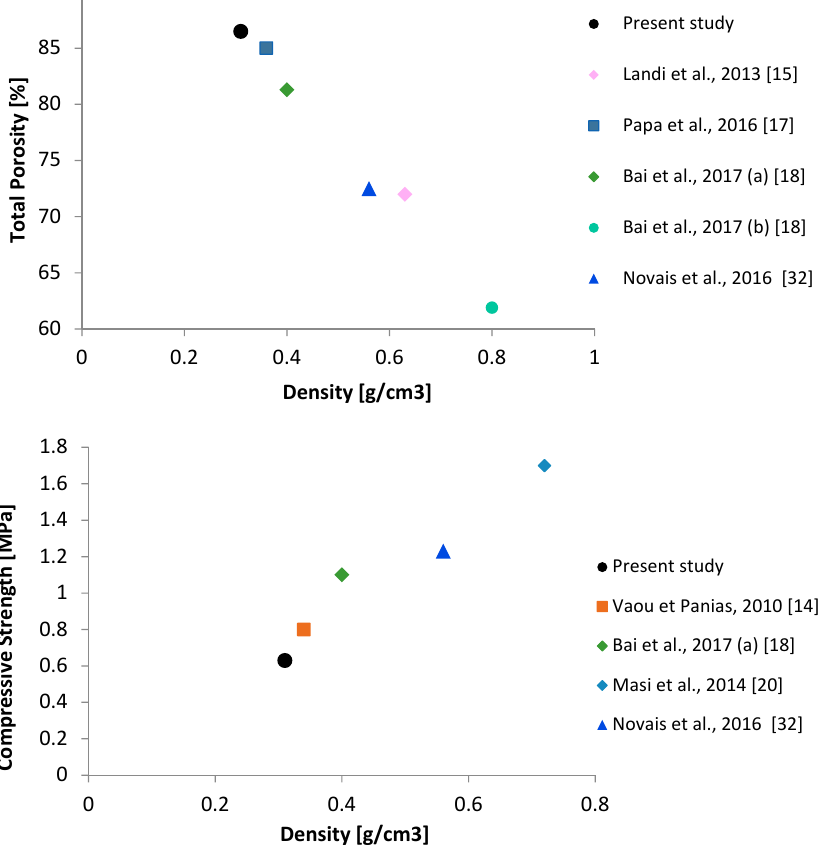
Figure 5. Open pore size distribution for MKBM50.